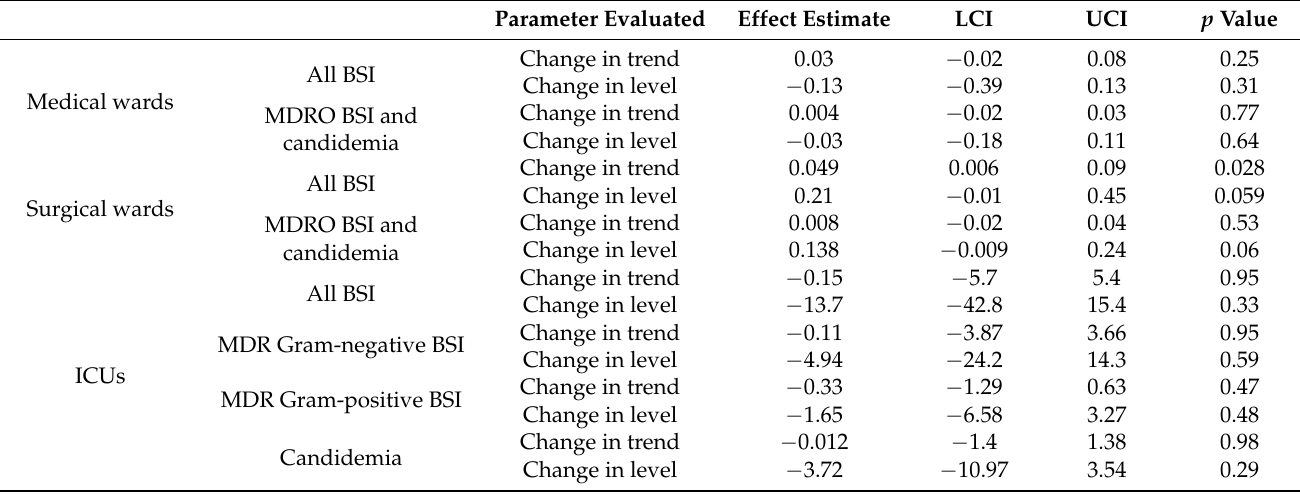
Table 5. Effect of the ASP interruption during COVID-19 pandemic on the rate of bloodstream infections (BSI) in medical, surgical and critical